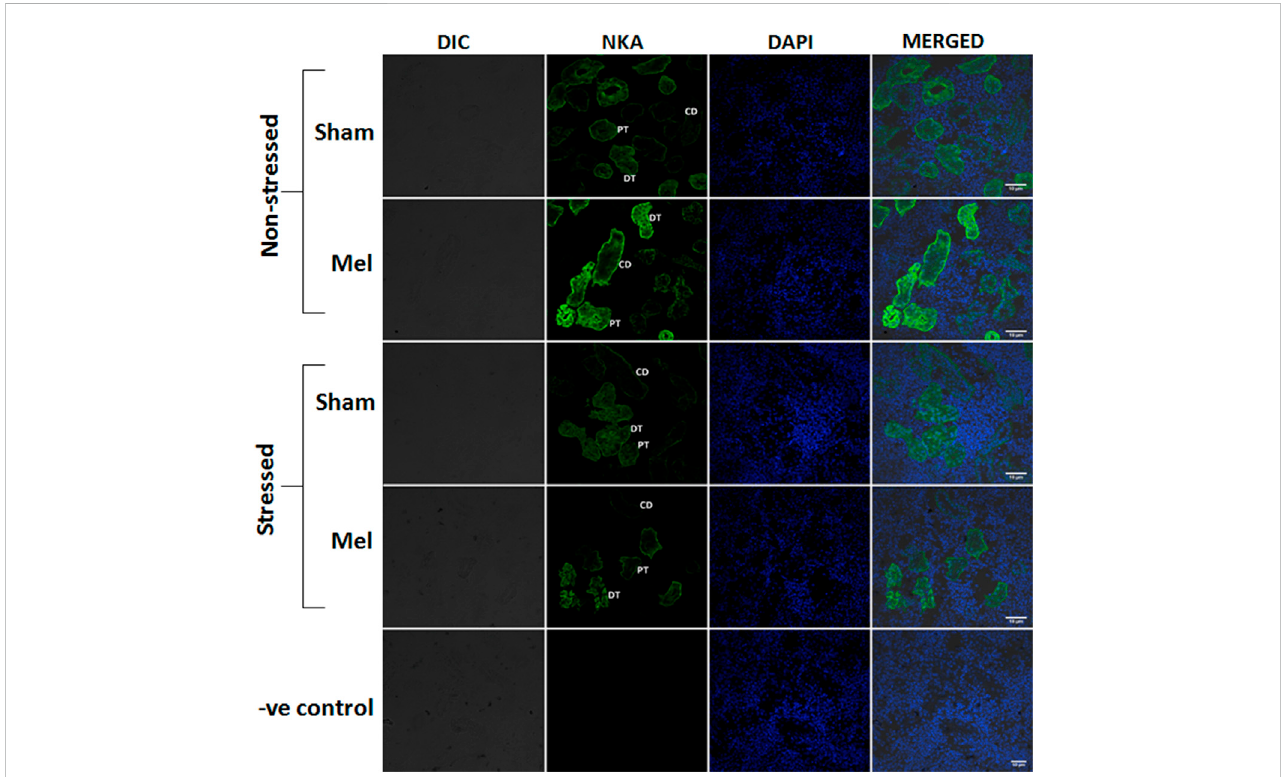
FIGURE 11 Confocal images showing the distribution pattern of NKA α 1 immunoreactivity in the different regions of tubules namely: proximal tubule (PT), distal tubule(DT)andcollectingduct(CD)inmelatonin-treated(Mel)non-stressed andimmersionstressed(IMR) fi sh.Cross-sectionofclimbingperchtrunkkidney immunostained with NKA α 1-antibody (green) showed region-speci fi c immunostaining of renal ionocytes that include renal proximal ionocyte, renal distal ionocyte and renal collecting duct ionocyte. Immuno fl uorescence staining for NKA α 1 is restricted to the basal membrane of renal epithelial cells in the proximal tubules that forms renal proximal ionocyte, whereas it extends to the basolateral membrane of renal epithelial cells in the distal and collecting tubules, which form renal distal and collecting duct ionocytes. Nuclei are counterstained with DAPI (blue). DIC and immuno fl uorescence images of NKA (green) and DAPI (blue) and its merged images were shown in each panel. Negative control kept under the same conditions without primary antibody that yielded no immunoreactivity was shown in the last panel. Scale bar = 10 μ